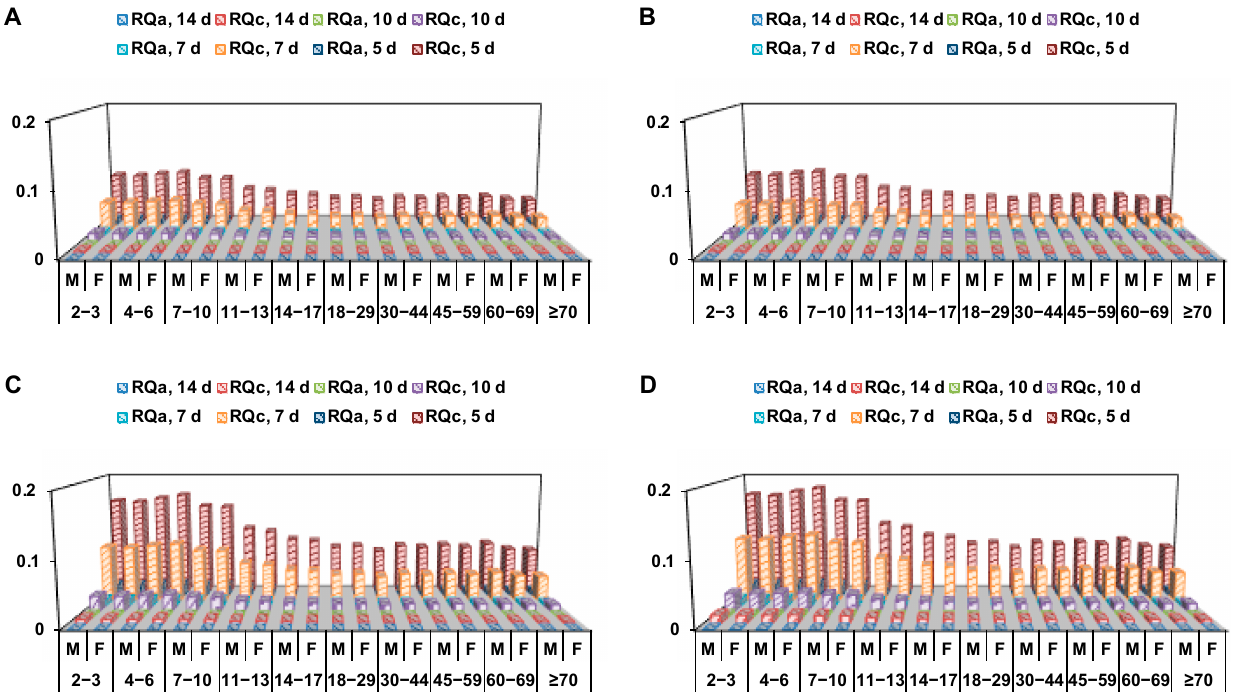
Figure 2. Visual diagram of acute and chronic risk quotient values of R -( − )-stereoisomer ( A ), S -(+)- stereoisomer ( B ), rac -penthiopyrad ( C ) and total (sum of racemic penthiopyrad and PAM) penthiopy- rad ( D ) in field-cultivated eggplant samples gathered from different treatments for different groups of Chinese consumers (M: Male and F: Female).